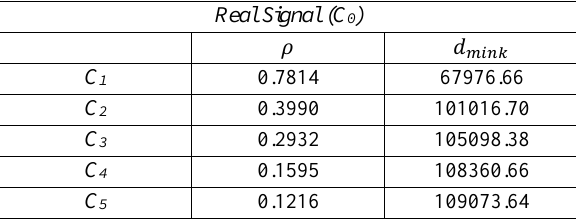
Table 1. The values of the correlation coefficient and the Minkowski distance for the precipitation